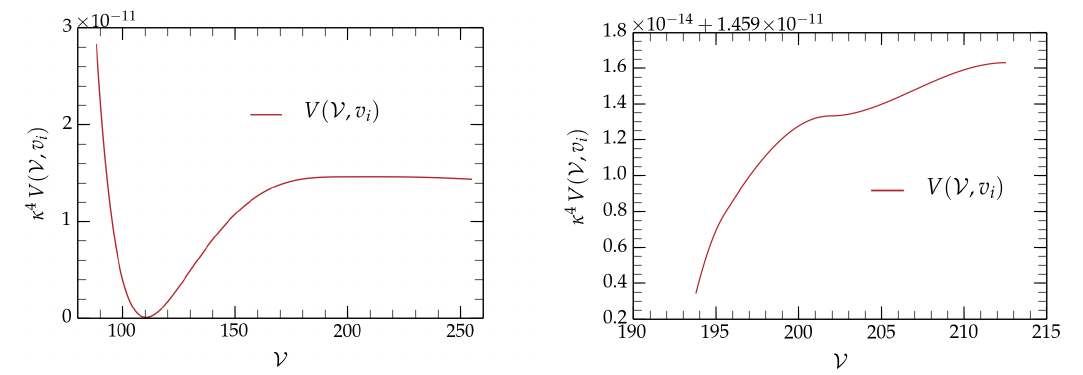
Figure 3 . Value V ( V , v i ) of the global minimum of the scalar potential as a function of the internal volume, for the parameters (5.32). We show (left panel) the almost vanishing value of the global minimum and focus (right panel) on the waterfall zone near V